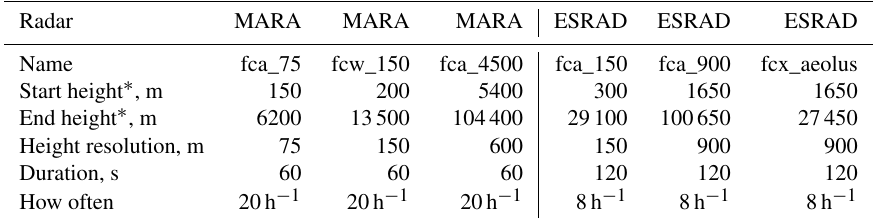
Table 1. Main characteristics of the radar operating modes used in the comparison. MARA (ESRAD) is located at 117m (295m) above the mean sea level. Note that due to technical problems, the mode fca_4500 did not operate at MARA from 24 June–2 September 2019.